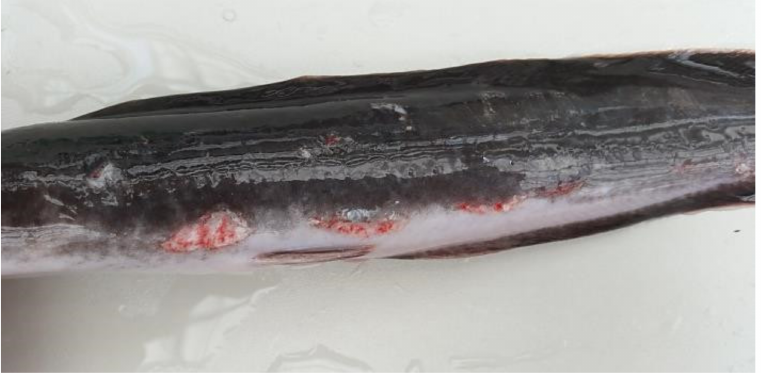
Figure 3. Skin lesions (bite marks) on an African catfish in the typical jaw form of this species as result of agonistic interactions. The photo was contrast-enhanced by 25%.